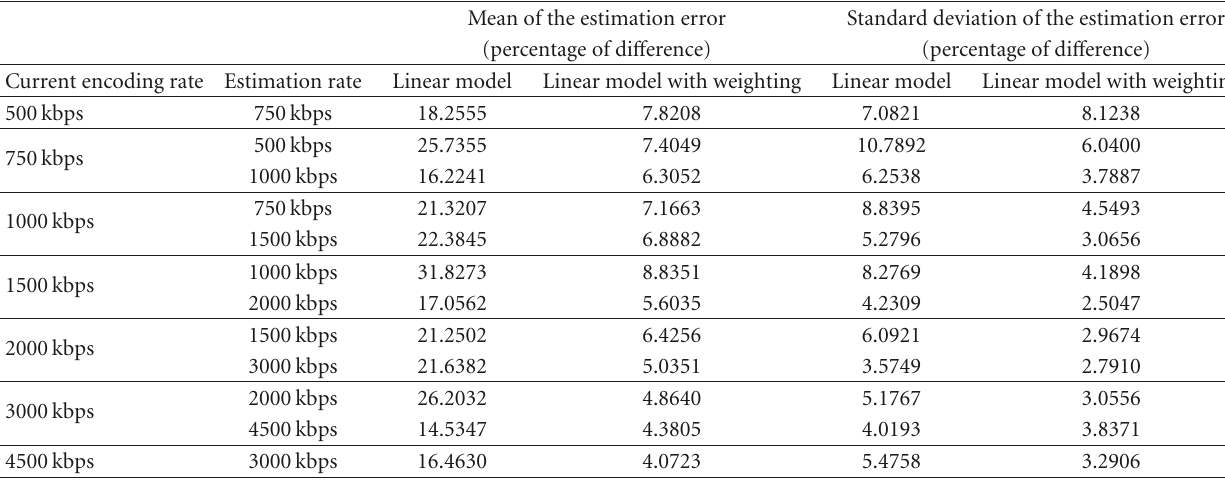
Figure 7: PSNR versus log (Bit rate) performance for 25 GOPs. 2 Table 2: Mean and standard deviation (calculated over the GOPs) of the estimation error (in percent) between the actual and the estimated MSE, foreman .